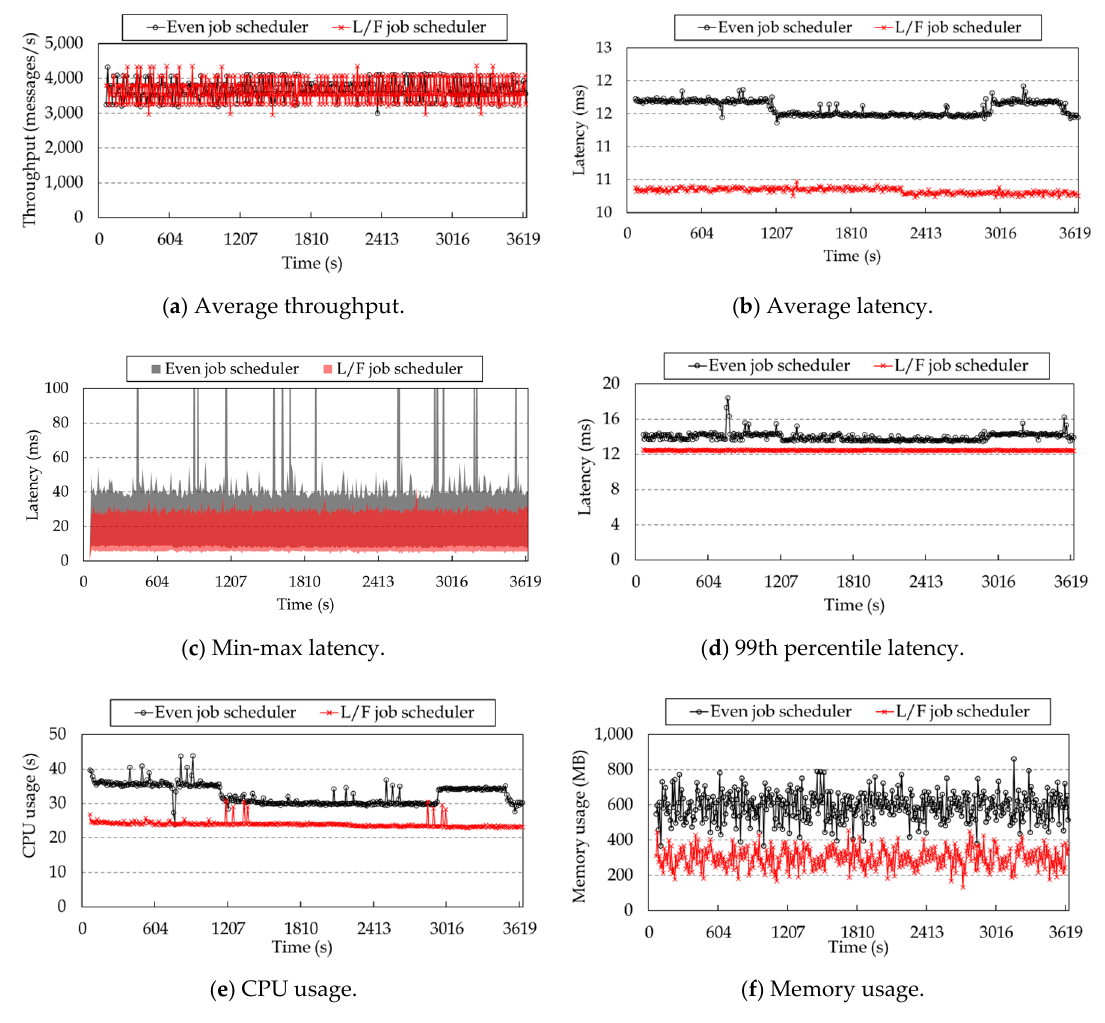
Figure 13. Performance of even and L/F job schedulers on unique page view count.